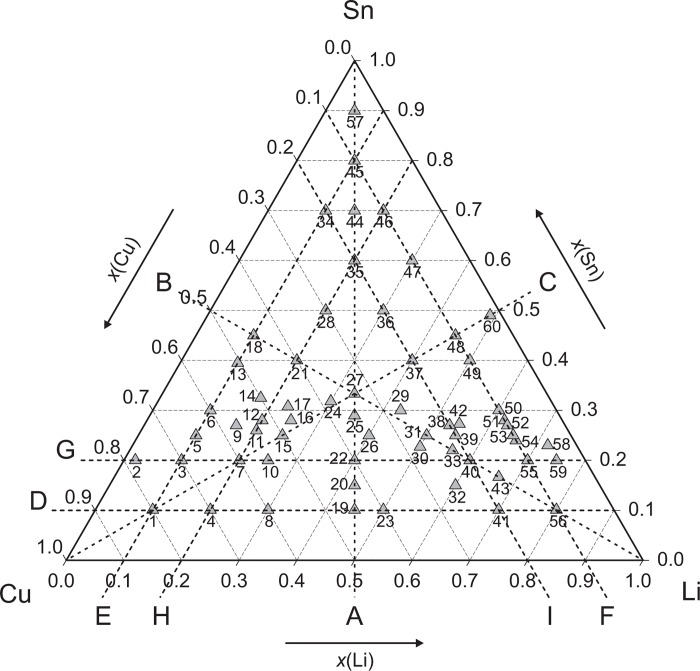
Sample compositions and isopleth sections (A: xCu: xLi = 0.5; B: xCu: xSn = 0.5; C: xLi: xSn = 0.5; D: xSn = 0.1; E: xLi = 0.1; F: xCu = 0.1; G: xSn = 0.2; H: xLi = 0.2; I: xCu = 0.2).